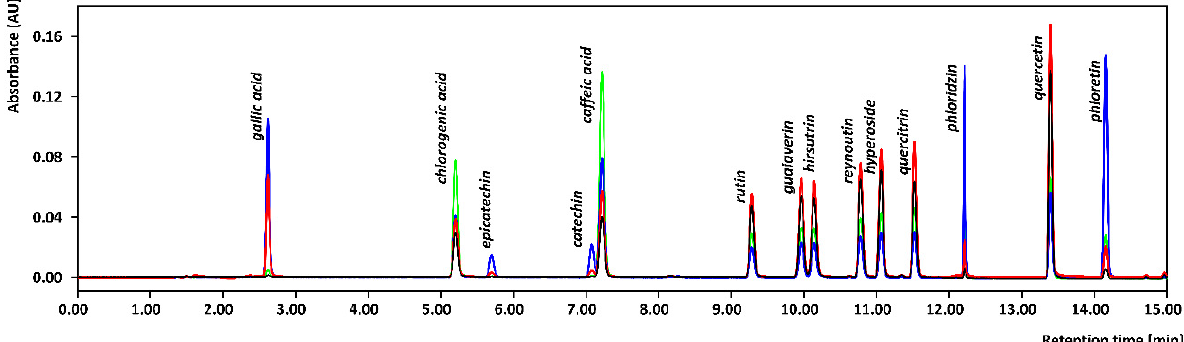
Figure 1. UHPLC-UV chromatogram of standards at a concentration of 10 µg/mL in MeOH–water + 0.1% formic acid (60/40, v / v ) using optimized separation conditions and detected at 4 different wavelengths: 254 nm in red, 280 nm in blue, 320 nm in green, and 354 in black.